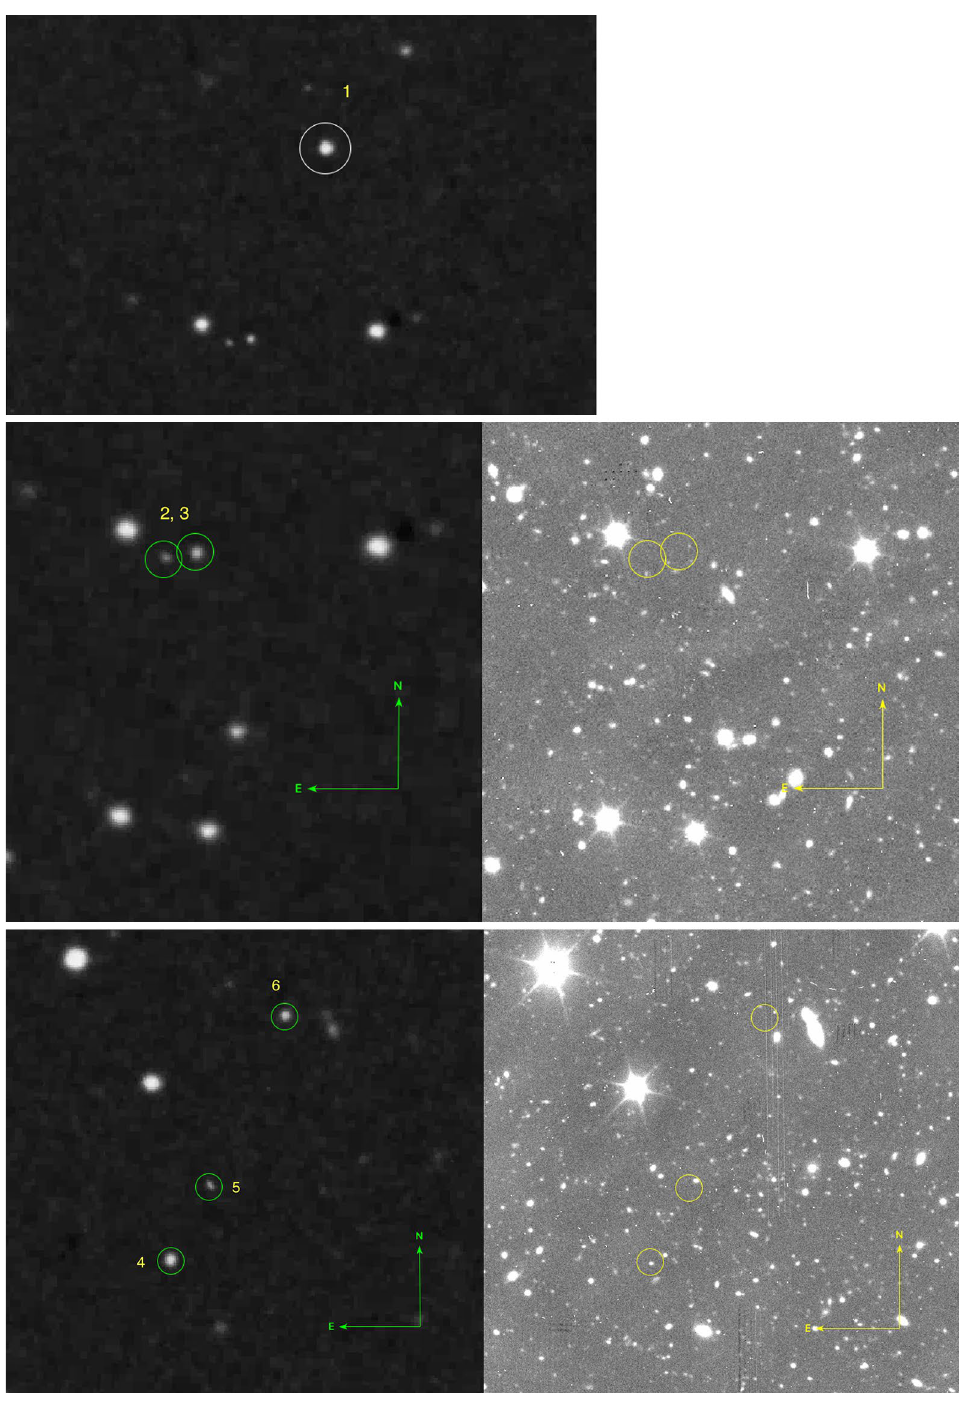
Figure 2. Transients number 1 − 6 Upper row: we see transient 1 in POSS-I (marked with a 10 arcsec circle), that is not covered by the GTC observations. Middle and lower row: the left images show the POSS-I red images and the right images show the GTC/OSIRIS g images. The transients are marked with circles with a radius of 5 arcseconds. The number of counterparts is 1 and 3 for transients 2 and 3. The number of counterparts is one each for transients 4, 5 and 6. Transient nr. 5 shows a slight elongation in the POSS-I image. The POSS-I image is based on the high-resolution SuperCosmos digitizations of the Palomar